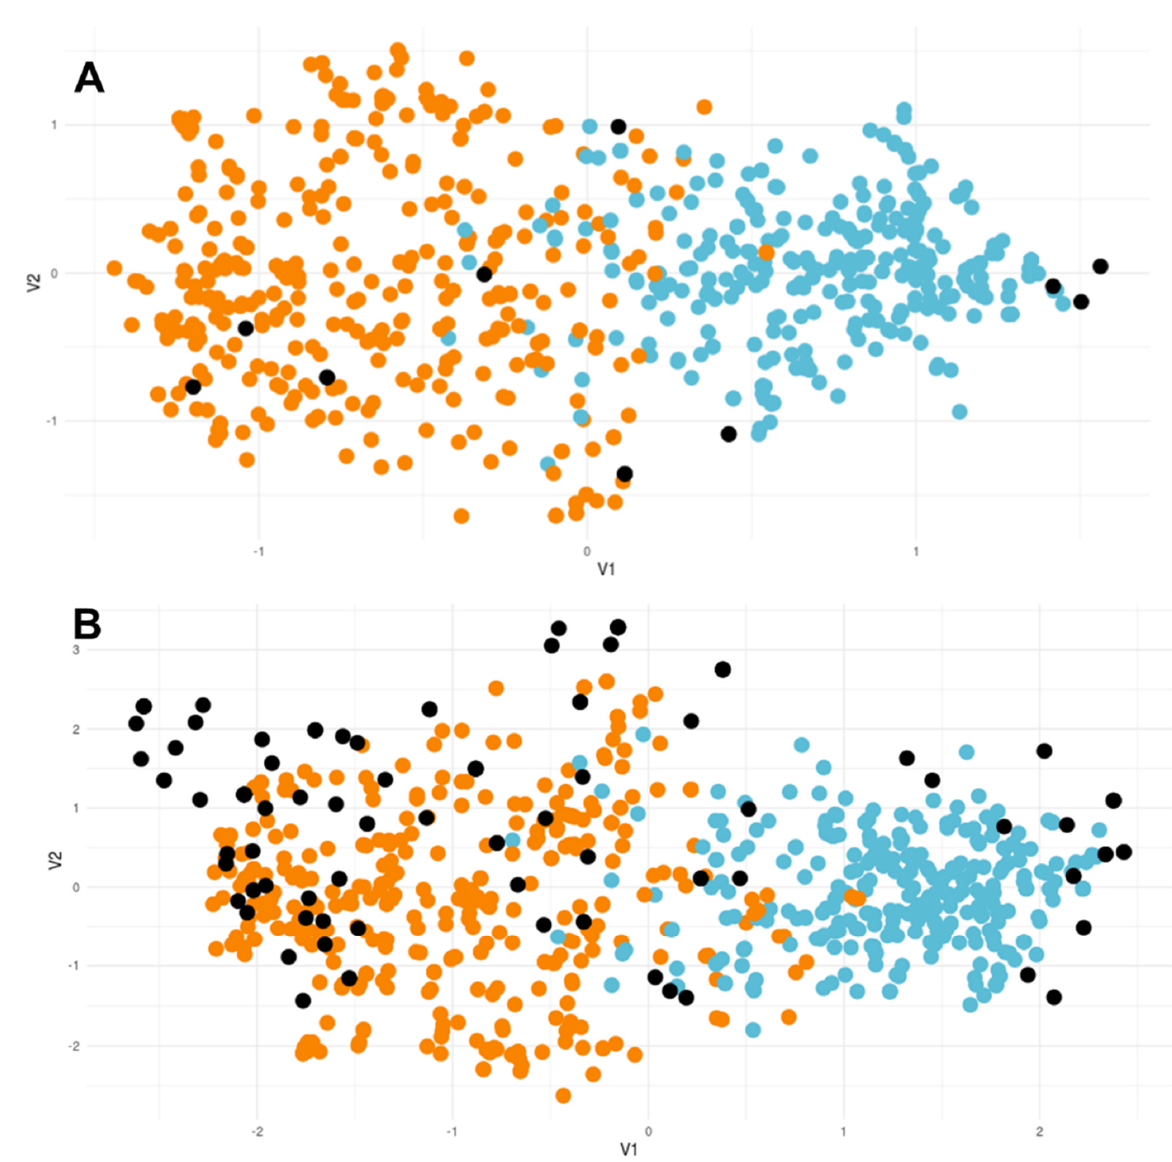
Figure 3. Representation of the isolates in this study (black dots) in the general population of the AfumID database. The orange clade represents susceptible isolates. The blue clade represents resistant isolates. ( A ). Set of isolates collected from COVID+ patients. ( B ). Set of all isolates in this study.